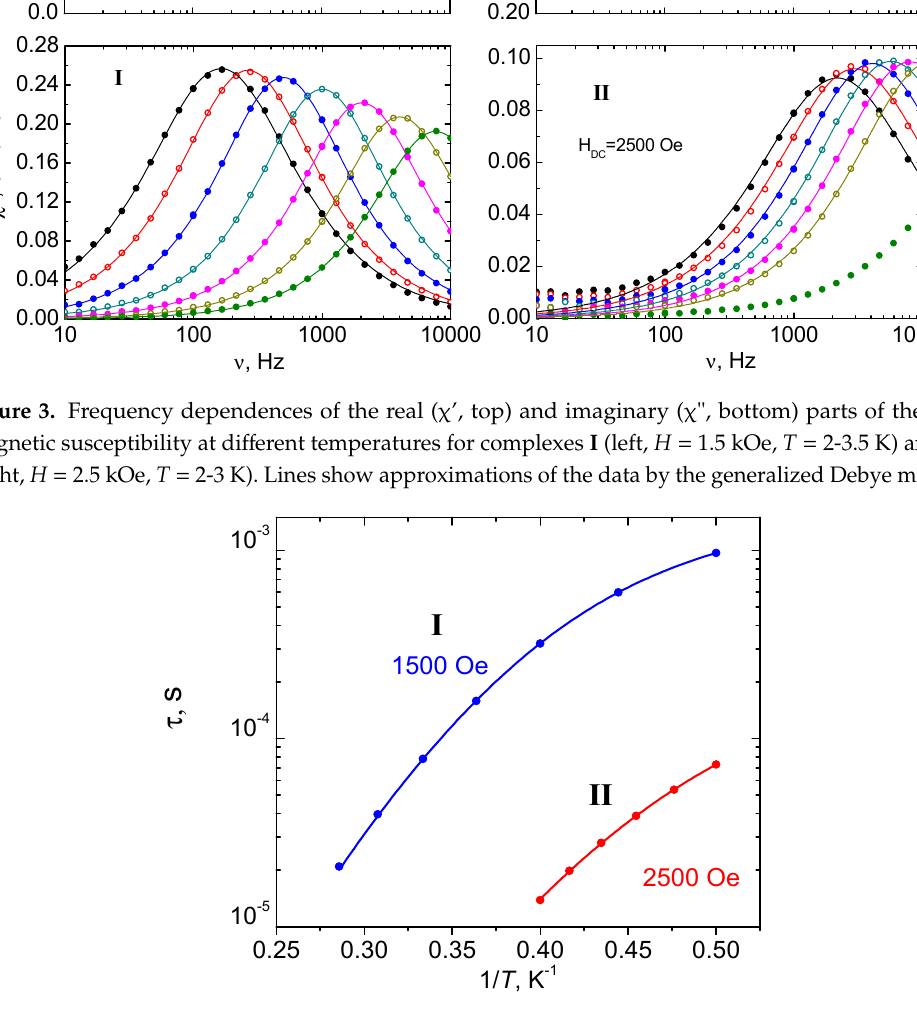
Figure 5. Voltammogram of I (solid lines, 2.1 mM at 0.05 M n -Bu 4 NBF 4 in MeCN, 50 mV/s, Pt) and Bu 4 NI (dashed line). When dissolved in acetonitrile, both iodine atoms at the cobalt atom are replaced by solvate acetonitrile molecules. This follows from the analysis of the voltammograms with a potential sweep into the anode region (Figure 5): The first two anode processes correspond to the oxidation of free iodide ions (I − /I 3 − and I 3 − /I 2 at potentials E pa = 0.36 V and 0.75 V, respectively). This is followed by an